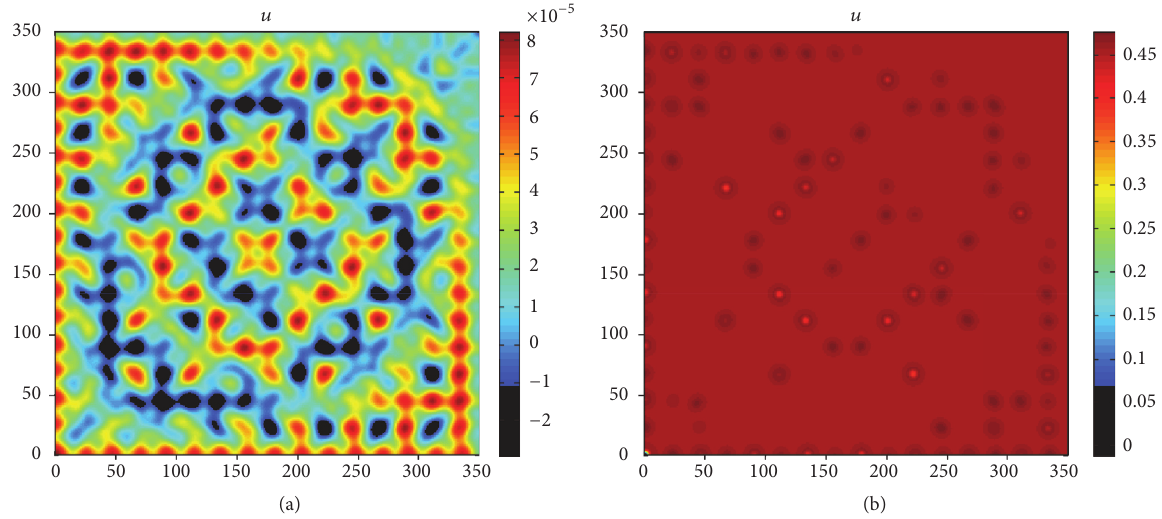
Figure 2: Parameter values and initial perturbation, respectively: 𝛼 = 3 , 𝛾 = 1 , 𝑑 1 = 1 , 𝑑 3 = 1 , 𝜎 = 1/2 , 𝑑 4 = 0.1 , 𝛽 = 2 , sin (𝑥𝑦) , and cos (𝑥𝑦) . (a) Pattern formation on the top domain when 𝑑 2 = 0.2 . (b) Pattern formation on the top domain when 𝑑 2 = 1 . Although the amplitude equation is stable, the effect of noise is